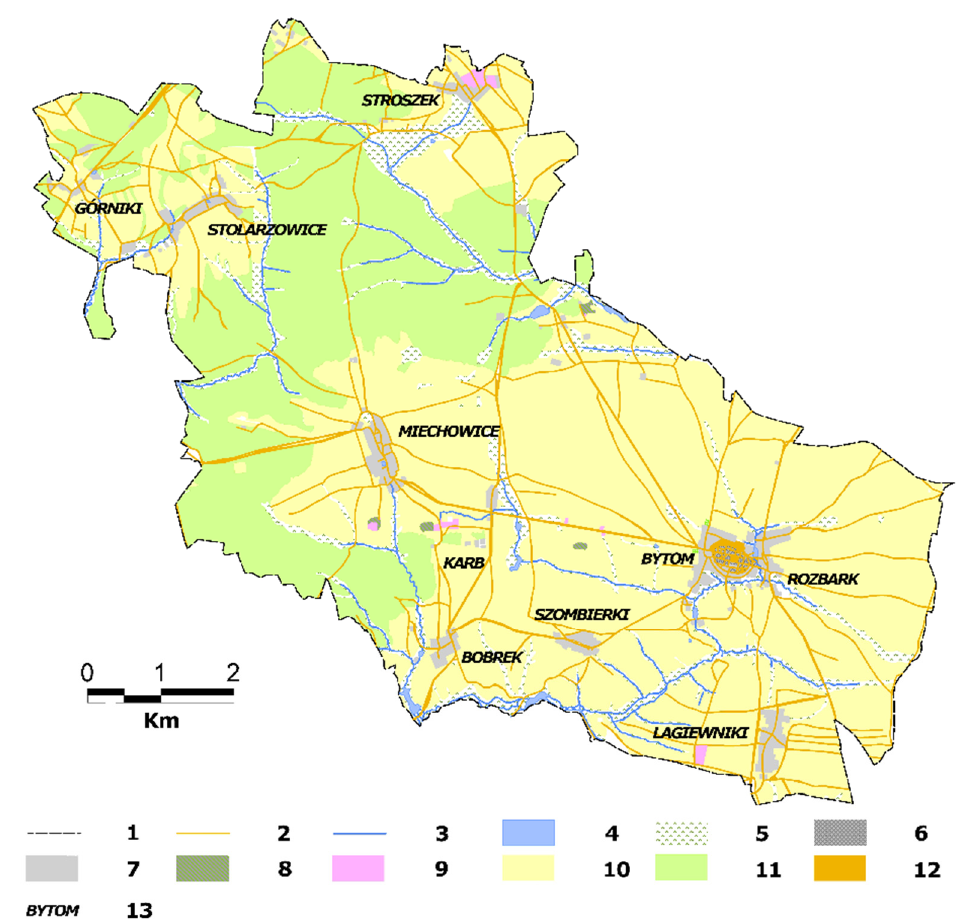
Figure 2. The land use of the area of Bytom in 1827 (Sourced by authors on the basis of: Preussische Reussische Ur-messtischblatter, 1827, 1: 25,000, sheet: 3309 Beuthen; 3308 Hindenburg; 3257 Broslawitz; 3258 Tarnowitz; Berlin). Explanations: 1—current city border, 2—dirt and hardened roads, 3—water courses, 4—water reservoirs, 5—meadows, 6—compact development, 7—dispersed development, cemeteries, 8—ore and zinc extractions and post-extractions wastelands, 9—industrial areas, 10—arable fields, fallow lands, 11—forests and trees, 12—road areas, 13—topographic names.